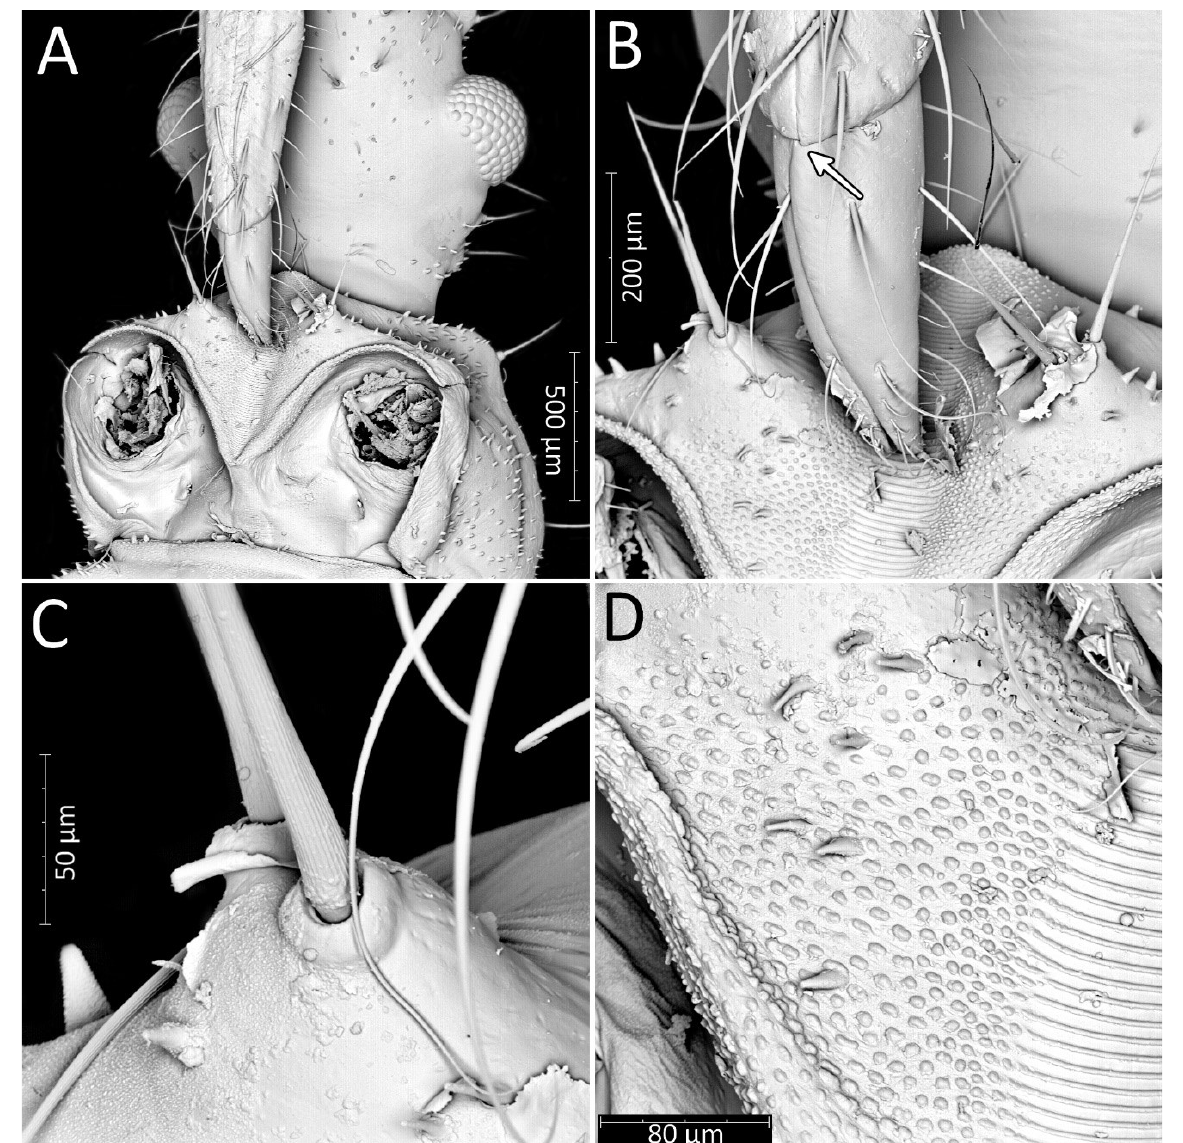
Figure 5. Psyttala horrida (Stål, 1865), first instar, SEM views. ( A ) Ventral view of the head with prosternum; ( B ) magnification of the tip of the labium and stridulitrum, with detail of membranous articulation between segments II and III; ( C ) magnification of two long setae near stridulitrum, with a clearly crimped structure; ( D ) stridulatory furrow with regular stripes and flanked by lateral papillae. Measurements (in mm): Body length 7.6–8.1; maximum width of abdomen 3.1–3.27; head length 1.72–1.75; head width 0.97–1.04; length of anteocular portion 0.82–0.86;